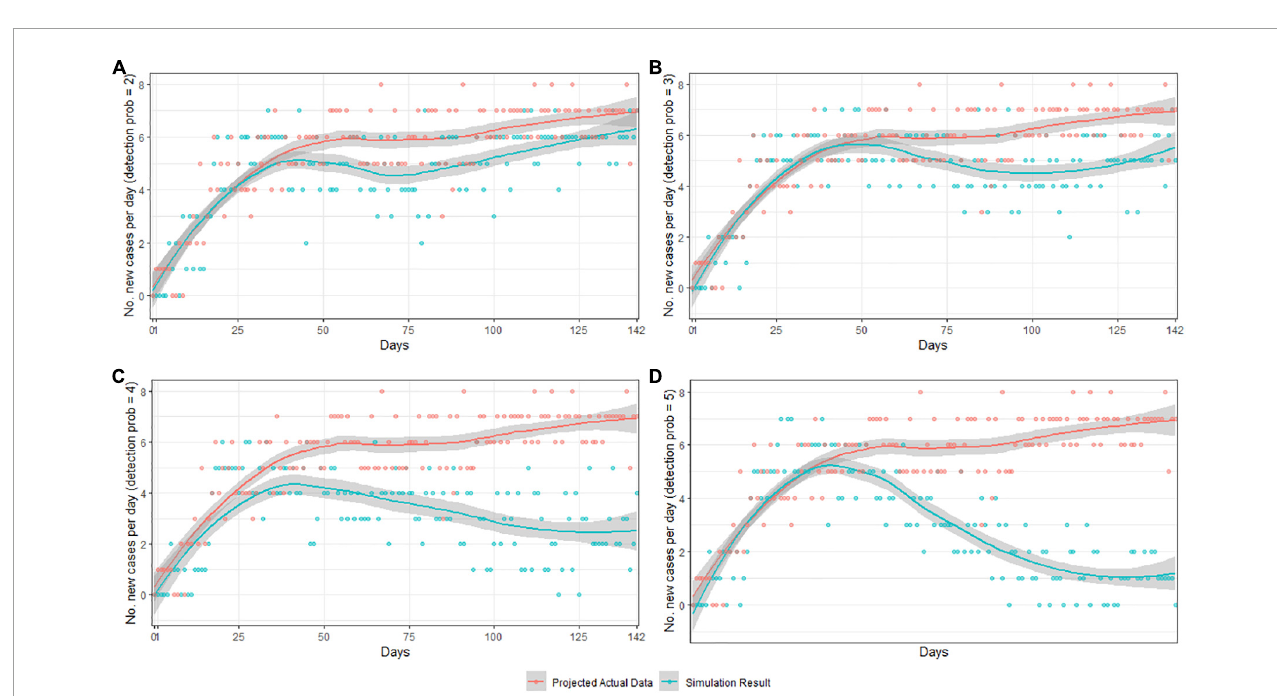
FIGURE6 Comparison between detected probability with value of (A) 2, (B) 3, (C) 4, and (D) 5, for the projection of daily new cases using actual data of total population (red line) and simulated data (blue line) during 143